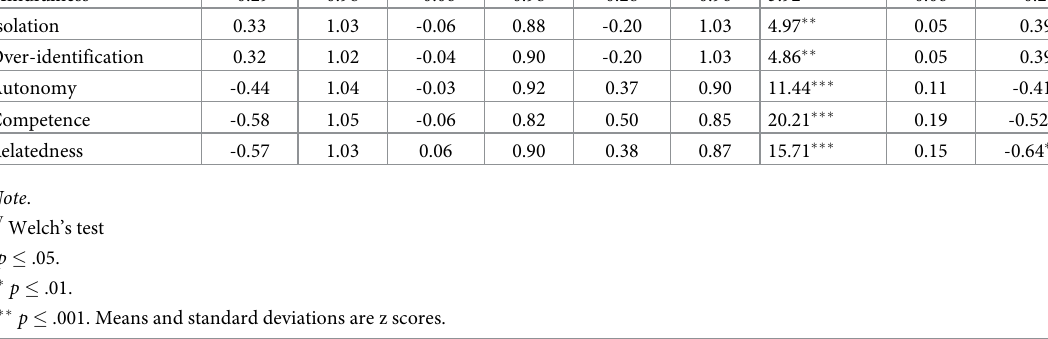
Table 3. ANOVA comparing the participants’ scores on self-compassion and self-determination according to their level of compassion satisfaction. Predictive variables Self-kindness Mindfulness Isolation